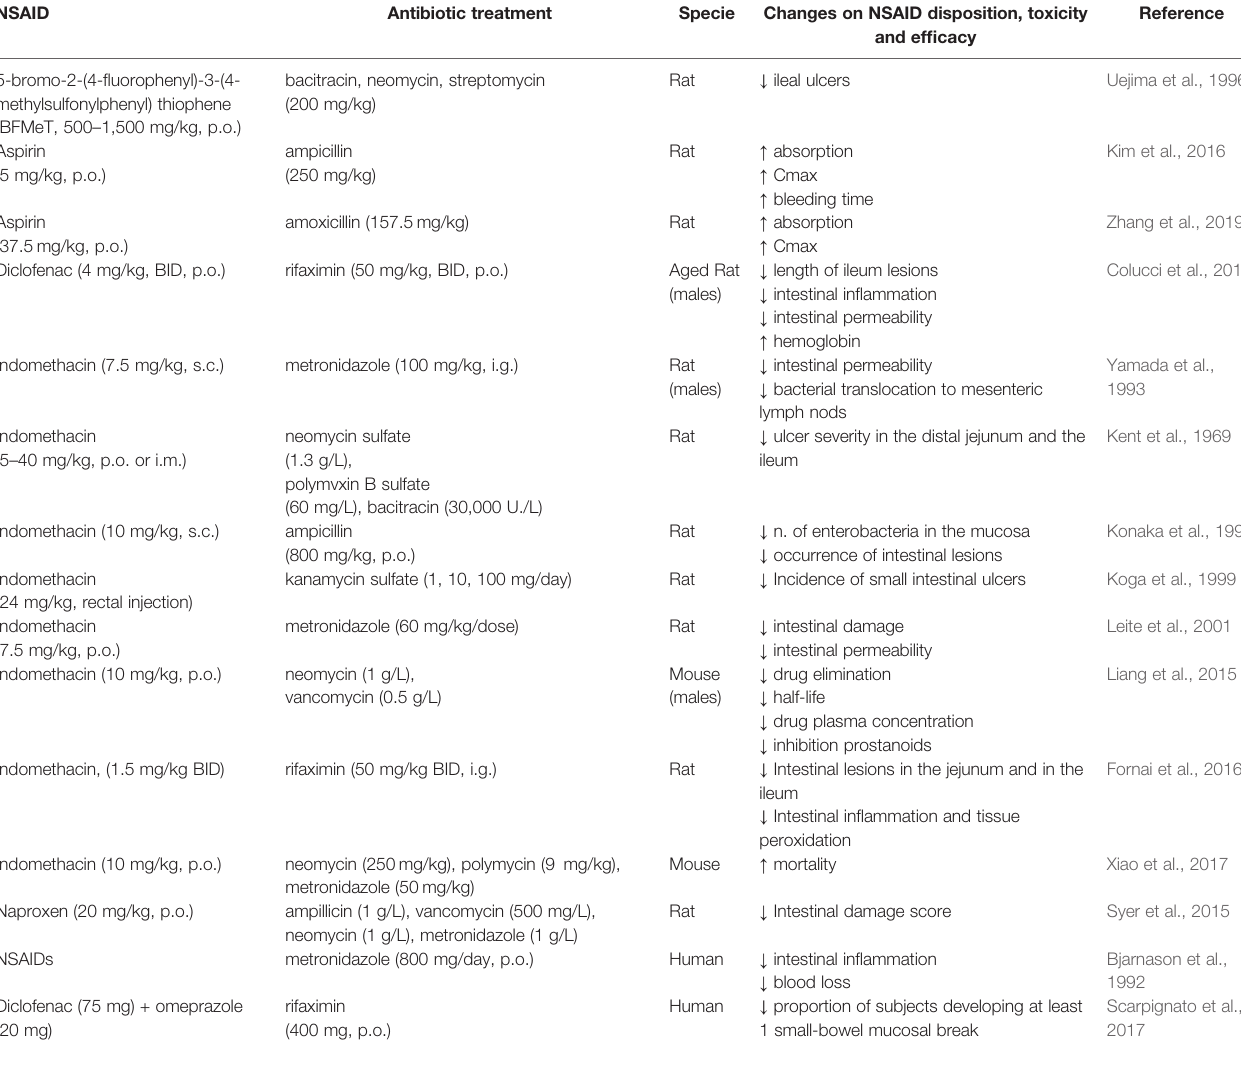
TABLE 3 | In vivo studies reporting the impact of antibiotic treatment on NSAID disposition, toxicity and ef fi cacy.